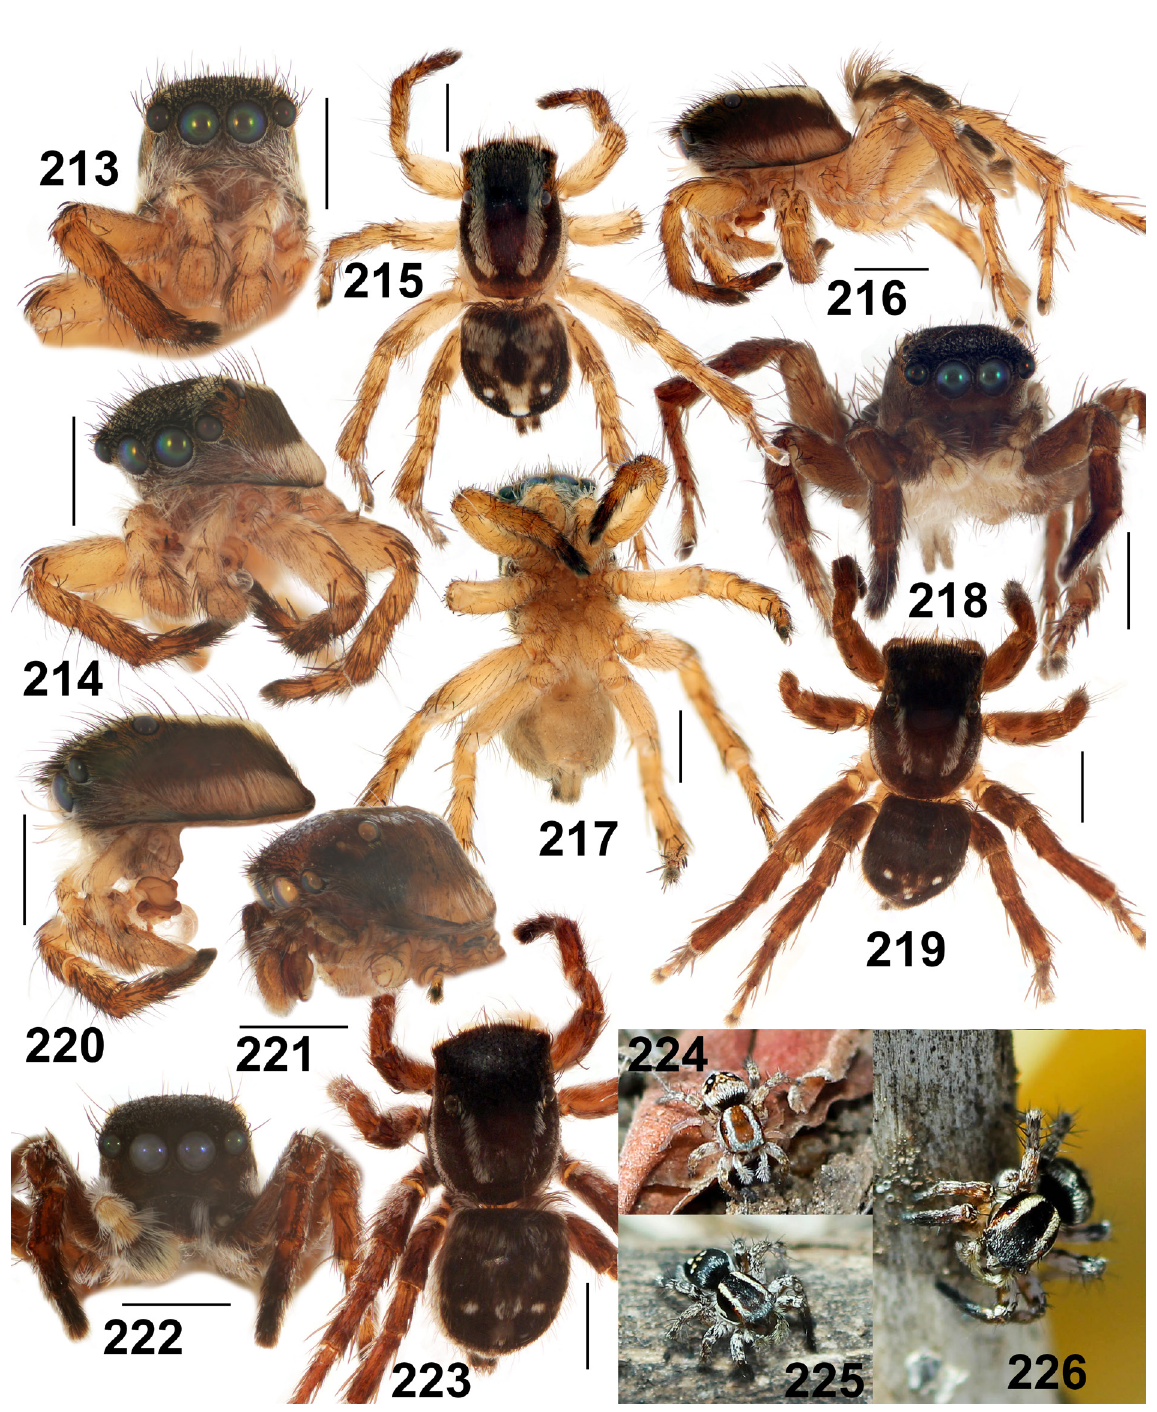
Figs 213–226. Stenaelurillus guttiger (Simon, 1901), ♂♂, general appearance . Specimens: 213–217, 220–221 from Botswana (Francistown; NCA 2009/3744); 218, 222–223 from South Africa (Ophathe GR; NCA 2007/2973); 219 from South Africa (Kruger NP, Letaba; NCA 2007/2284); 224–226 from South Africa (Kruger NP, Shingwedzi Camp), photos © Galina Azarkina, juvenile (224) and two adult ♂♂ (225–226). Scale bars: 1